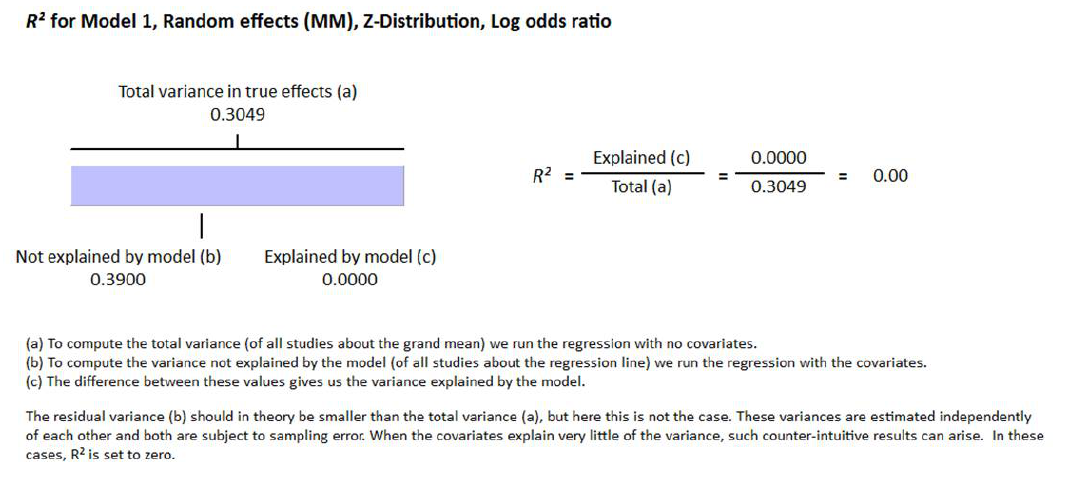
Figure 4. Meta regression analysis for the moderator method of determination of vitamin D, R-Squared represents the contribution of method of determination of vitamin D to the variability of